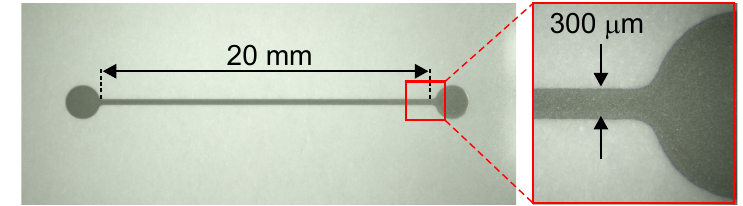
Figure 9. Screen-printed strain sensor entirely made of silver ink.